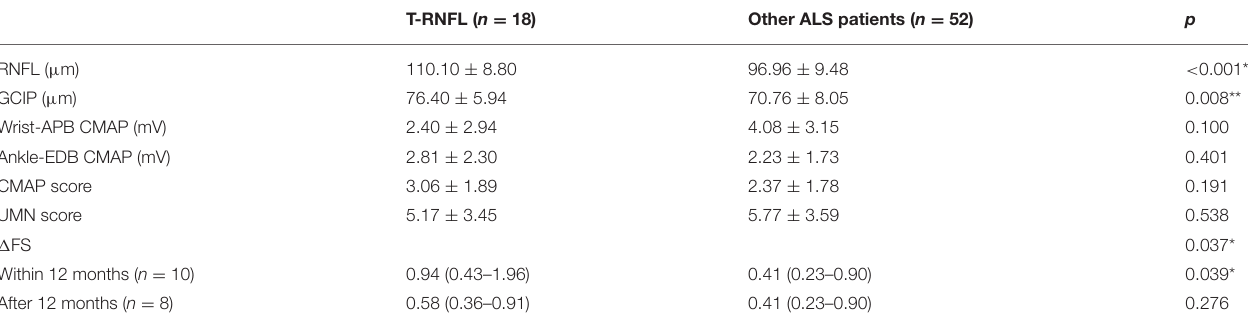
TABLE 3 | Comparison of RNFL, GCIP and disease parameters between the T-RNFL group patients and the other ALS patients. T-RNFL ( n = 18) Other ALS patients ( n = 52) p 110.10 ±